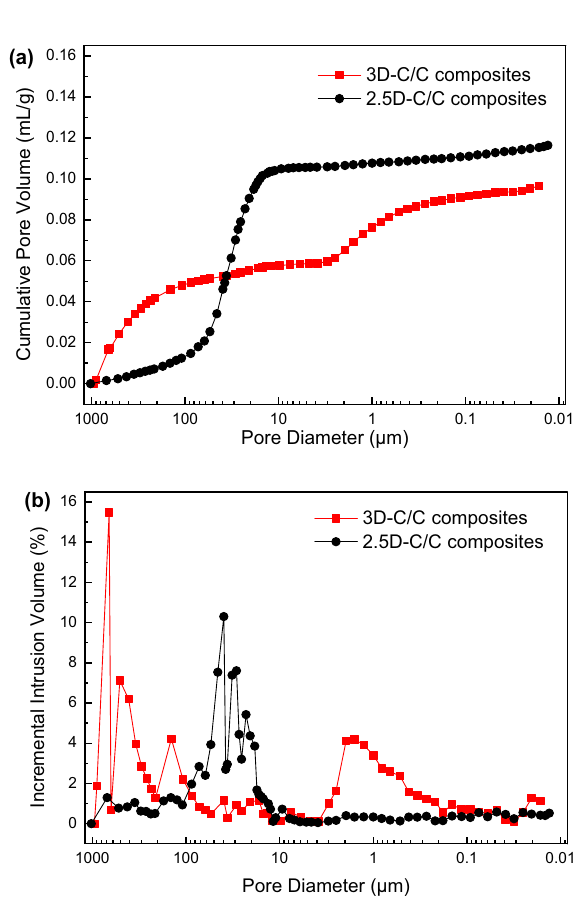
Figure 3. Pore analyses of 3D and 2.5D-C/C composites, ( a ) cumulative pore volume; ( b ) incremental intrusion volume,